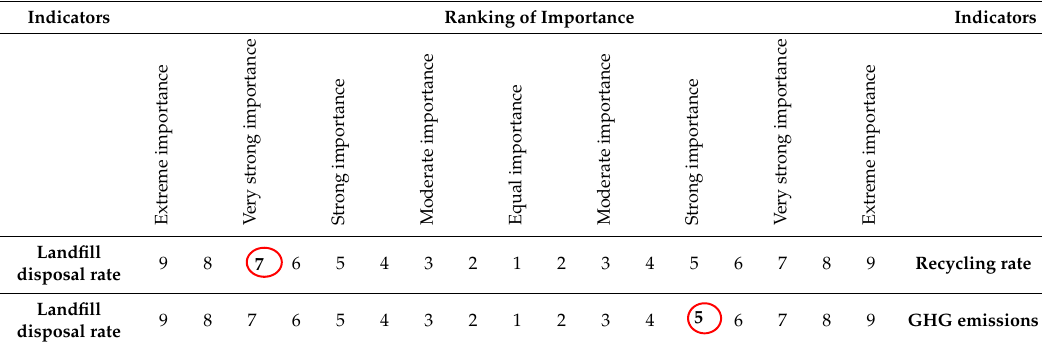
Table 2. Example of ranking questionnaire for the experts.